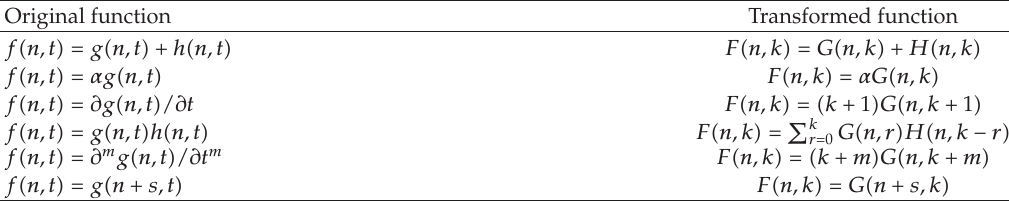
Table 1: The operations for generalized di ff erential transform